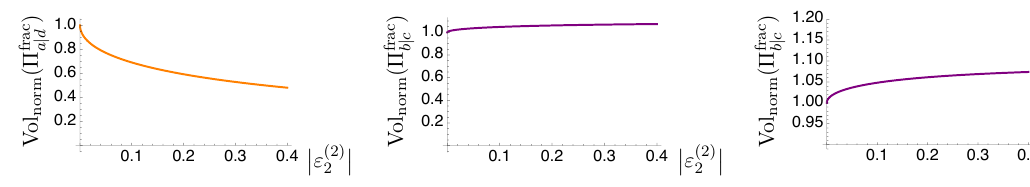
(cid:26) 1 (cid:0) = a j d